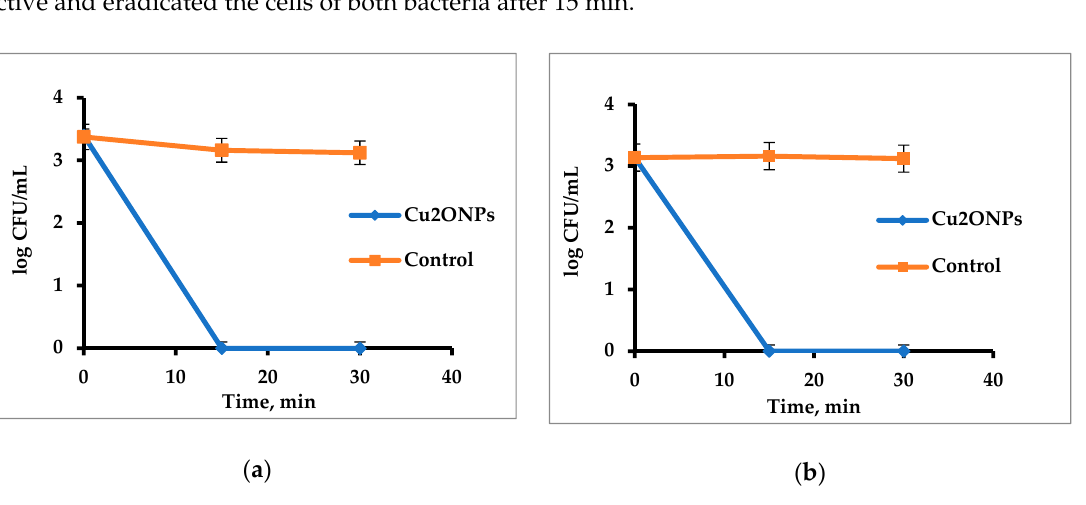
Figure 5. Activity of free Cu 2 ONPs against ( a ) Staphylococcus aureus and ( b ) Escherichia coli cells. Control—untreated bacterial cells.